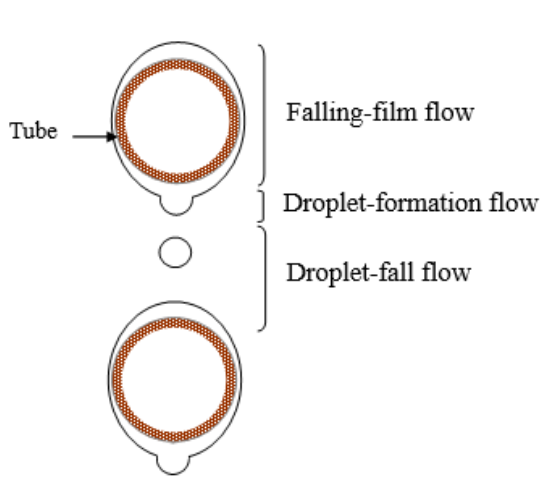
Figure 3. Flow regimes in horizontal tube falling ‐ film absorbers.